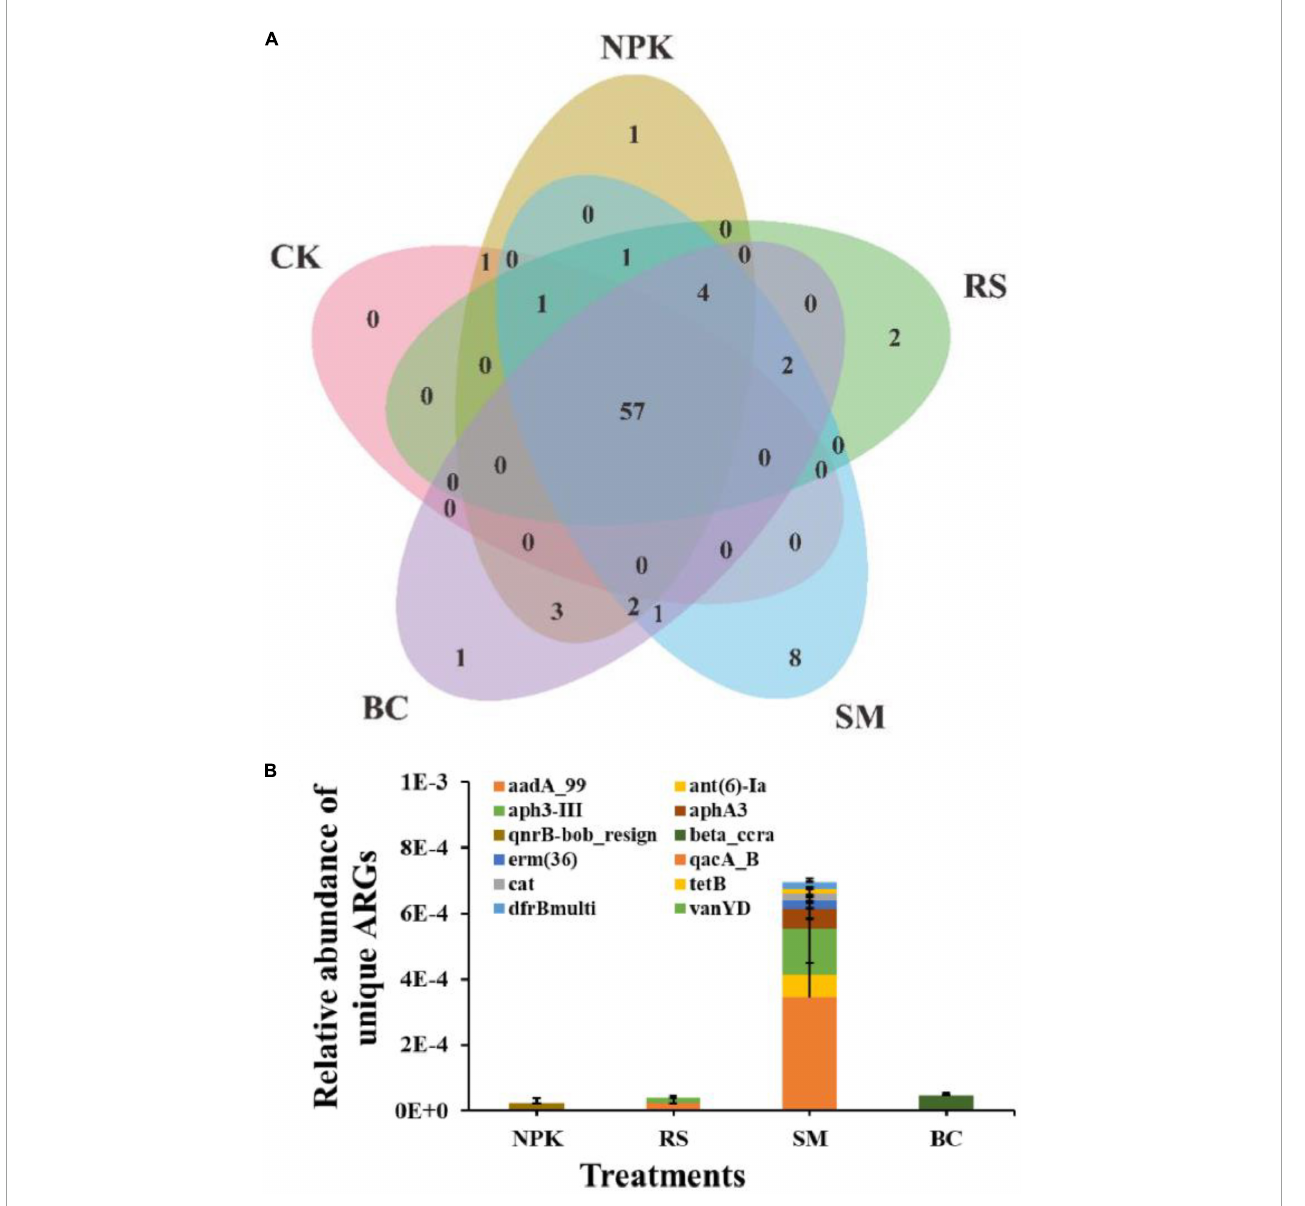
FIGURE2 A Venn diagram showing the ARG numbers shared by different treatments (A) , and the relative abundance of unique genes detected in different treatments (B)